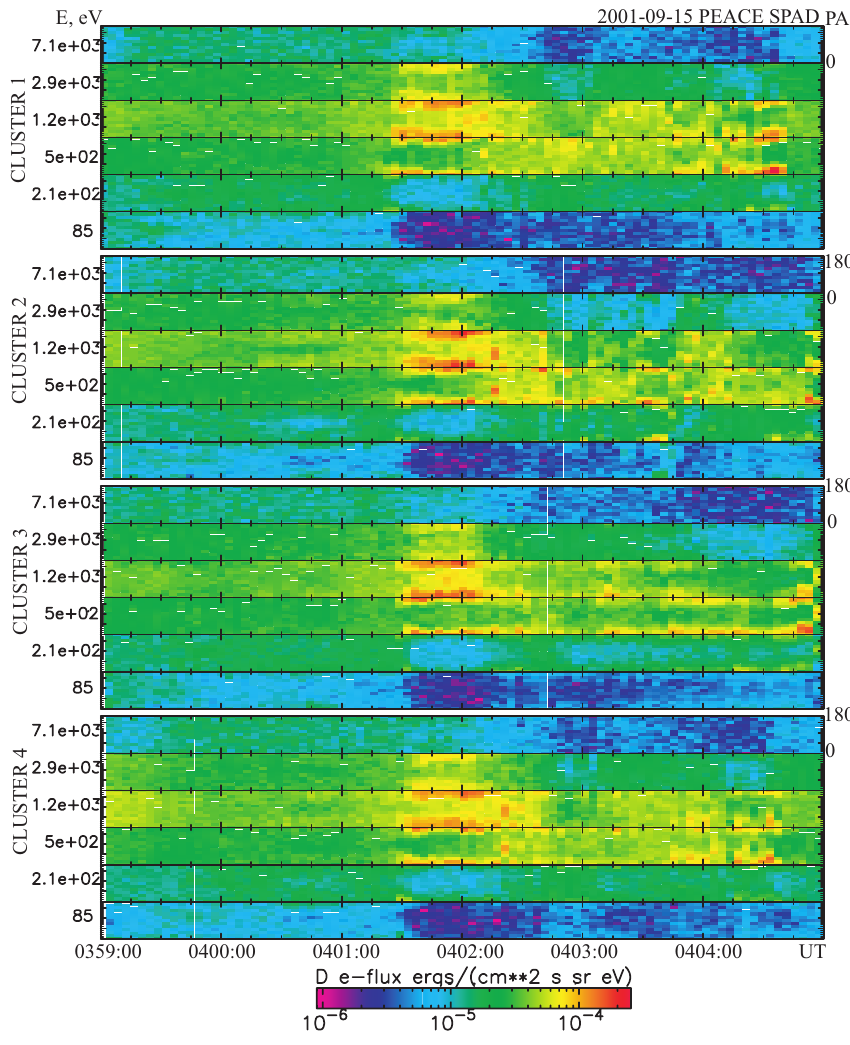
Fig. 13. Cluster PEACE PAD energy-time spectrograms, interval C